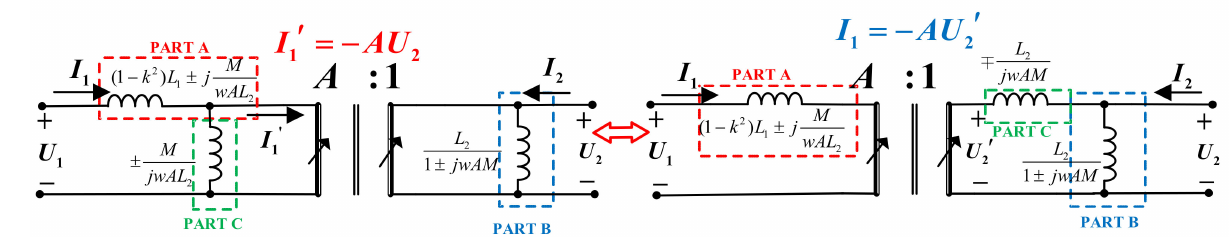
Figure 10. Equivalent circuit of the LCT from constant voltage to constant current.